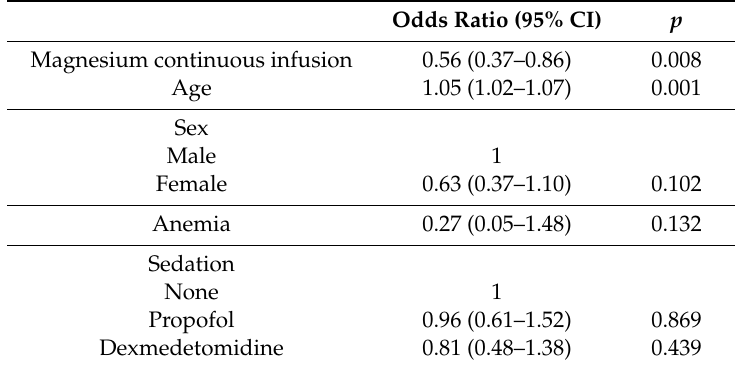
Table 4. Results of multivariate analysis of variables associated with urinary